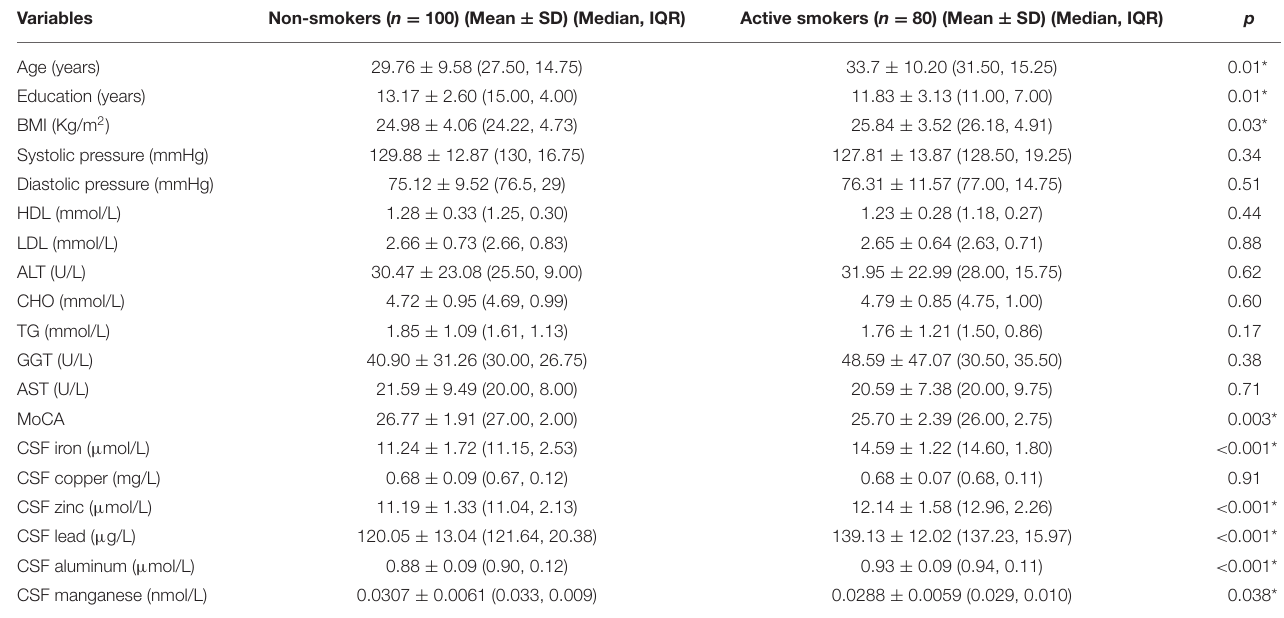
TABLE 1 | The differences of clinical characteristics between non-smokers and active smokers.